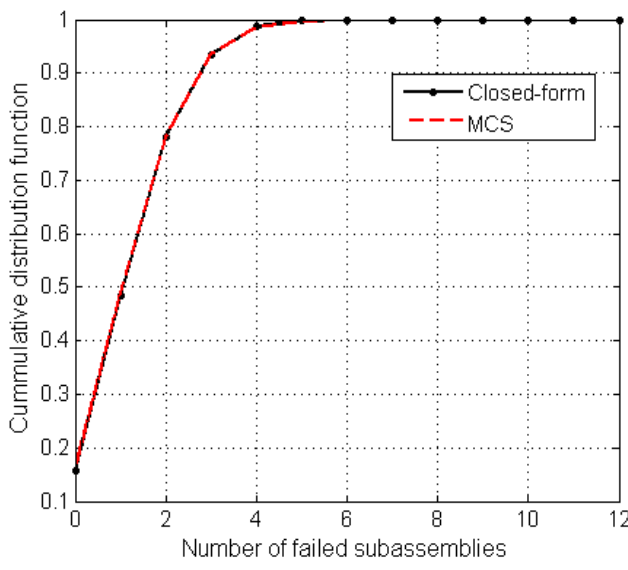
Figure 2. Comparison of annual system failure CDFs obtained by the closed-form technique and a naïve Monte Carlo simulation (MCS)